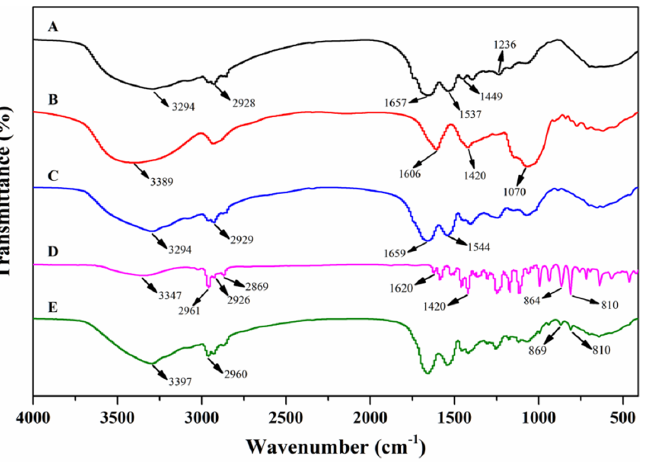
Figure 6. FTIR spectra of WMPI ( A ), GA ( B ), WMPI-GA coacervates ( C ), carvacrol ( D ), and carvacrol microcapsules ( E ).